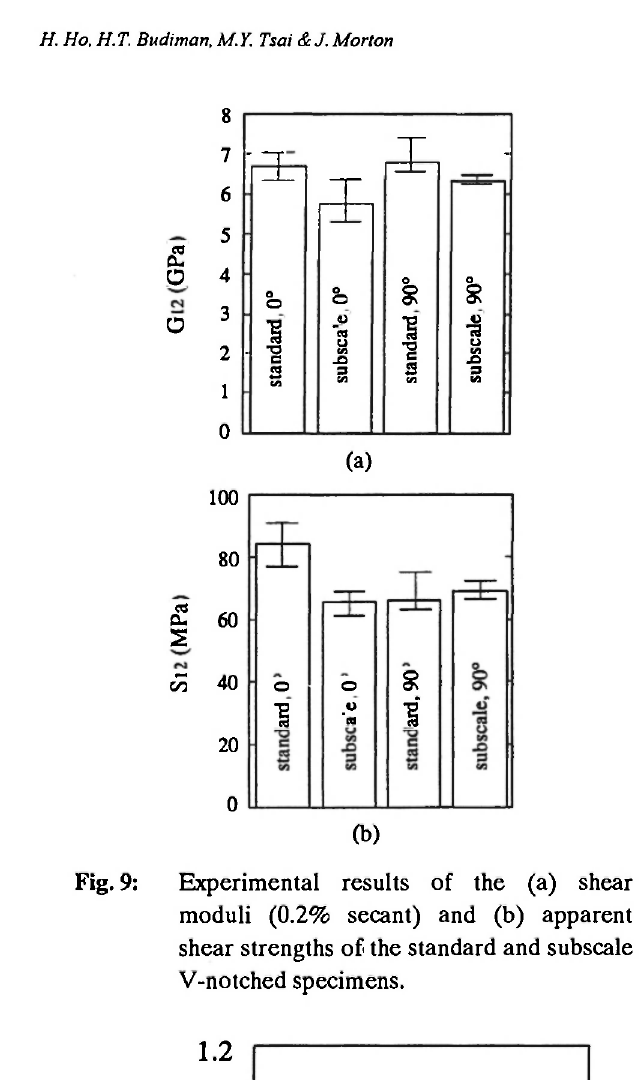
Fig. 9: Experimental results of the (a) shear moduli (0.2% secant) and (b) apparent shear strengths of the standard and subscale V-notched specimens.